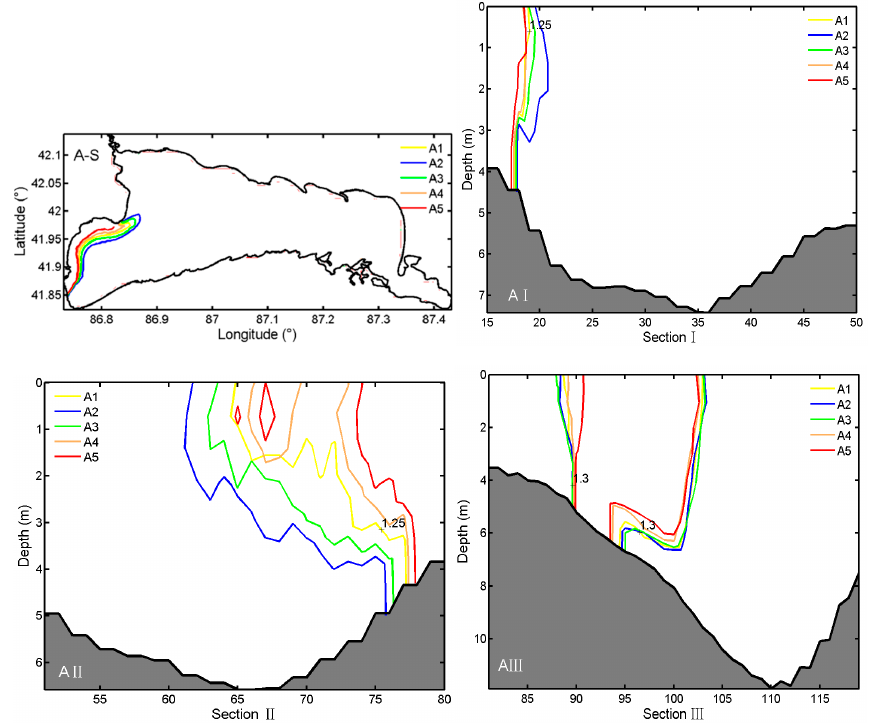
Figure 14. Distribution of modeled salinity at Section III in experiment ( A2-III ) A2, ( A3-III ) A3, ( A4- III ) A4, and ( A5-III ) A5.